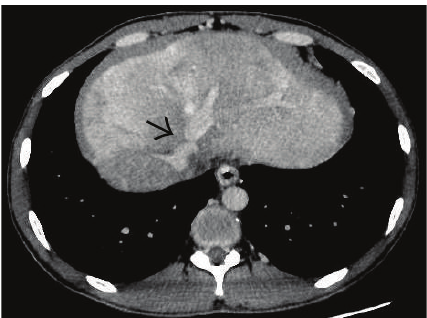
Figure 20: Axial CECT image demonstrating a web in the left hepatic vein (arrow) with heterogeneous hepatic parenchymal enhancement.